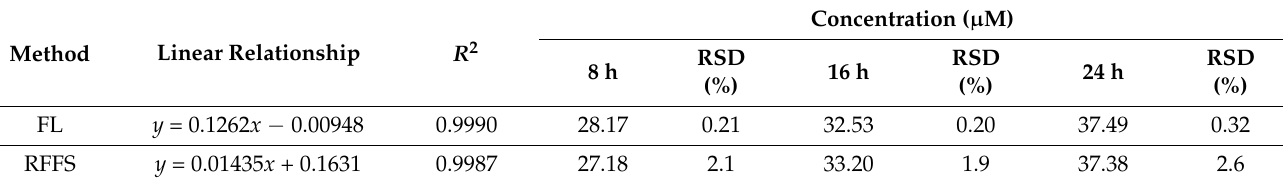
Table 1. Comparison of the results in water samples detected with two methods ( n =